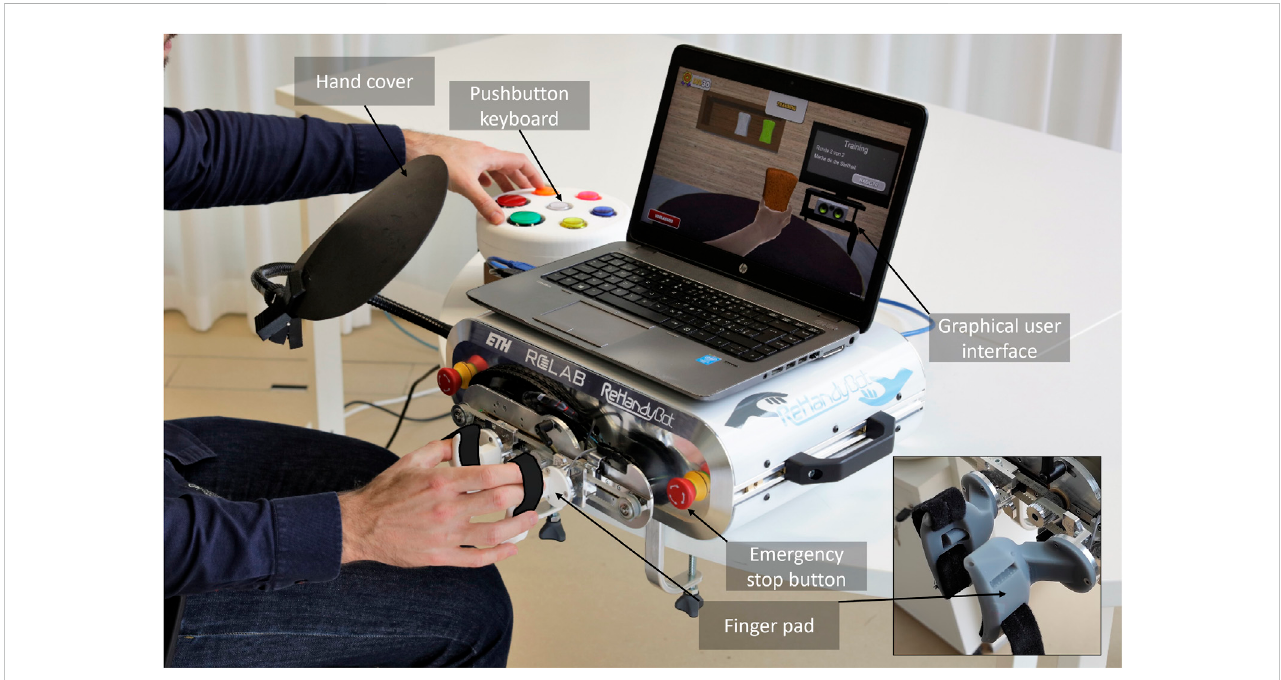
A subject performing a rehabilitation exercise (sponge exercise) with the ReHandyBot, which includes physical (i.e., instrumented fi nger pads, colored pushbutton keyboard) and graphical user interfaces (GUIs) and a set of therapy exercises that can be used without supervision. During the speci fi c sponge